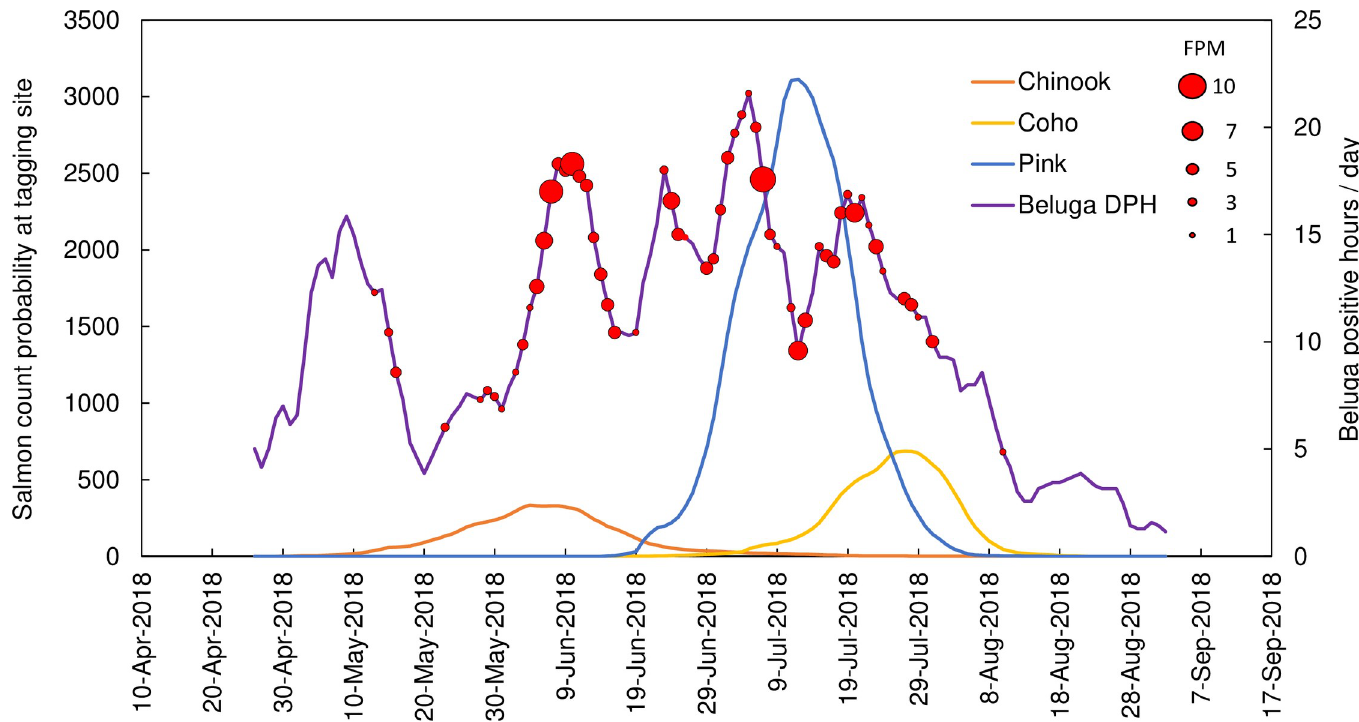
Fig 8. Predicted number of salmon per day at the tagging site at Susitna River for the five Pacific salmon species (fish/day), beluga daily presence in detection positive hours (DPH) per day, and feeding occurrence (FPM) per day (variably sized red filled circle). Note: chum and sockeye sustained very low predicted number of salmon per day at the tagging site and were omitted here.